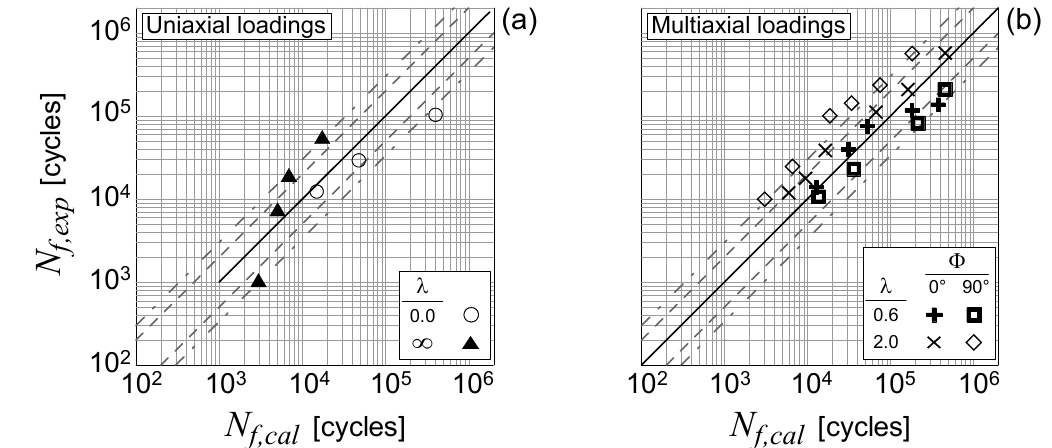
Figure 1: Comparison between theoretical and experimental fatigue life: (a) uniaxial loadings; (b) multiaxial loadings.